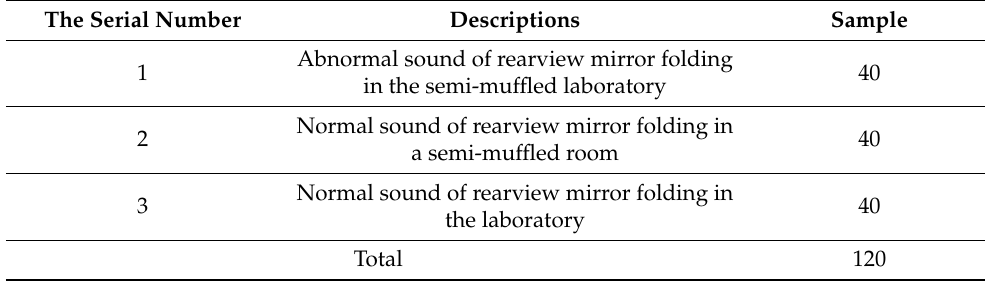
Figure 3. Experimental setup. Semi-muffled laboratory (experimental setup 1), and laboratory (experimental setup 2). Table 2. Description of the Working